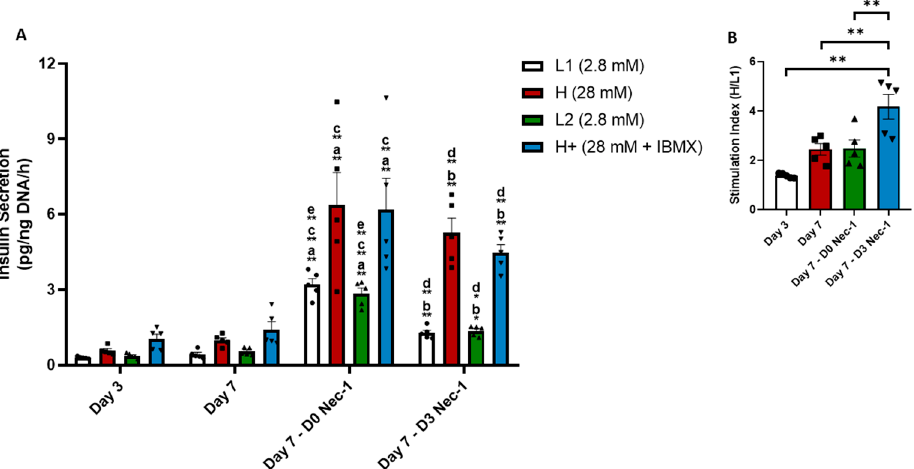
Figure 6. Function of PPIs in response to glucose challenge on day 3 and 7 of tissue culture in control media or media supplemented Nec-1 either immediately after islet isolation (D0 Nec-1) or on day 3 of tissue culture (D3 Nec-1). Islet function was evaluated using a glucose stimulated insulin release assay. A triplicate of 100 IEQs was incubated for 1 h in media with the corresponding order of glucose concentration: 2.8 mM (L1), 28 mM (H) 2.8 mM (L2), and 28 mM + 0.1mM IBMX (H+), glucose media. The concentration of secreted insulin from each media condition was quantified by ELISA and normalized to the sample DNA content. ( A ) Insulin secretion per ng DNA after incubation in varying concentrations of glucose media released by PPIs on day 3 and 7 of tissue culture. Individual data points for islet insulin secretion in 2.8 mM (L1), 28 mM (H) 2.8 mM (L2), and 28 mM + 0.1mM IBMX (H+), glucose media are shown within each bar graph as either circles, squares, triangles, or inverted triangles, respectively. ( B ) Stimulation index, calculated as the insulin secretion in H media over L1 media, of PPIs on day 3 and 7 of tissue culture. n = 5 for each group. * p < 0.05. ** p < 0.01. Individual data points for islets cultured in control media on day 3 (Day 3) or day 7 of tissue culture (Day 7) or in media supplemented with Nec-1 either immediately after islet isolation (D0 Nec-1) or on day 3 of tissue culture (D3 Nec-1) are shown within each bar graph as either circles, squares, triangles, or inverted triangles, respectively. Data expressed as mean ± SEM. a. Day 3 vs. Day 7-D0